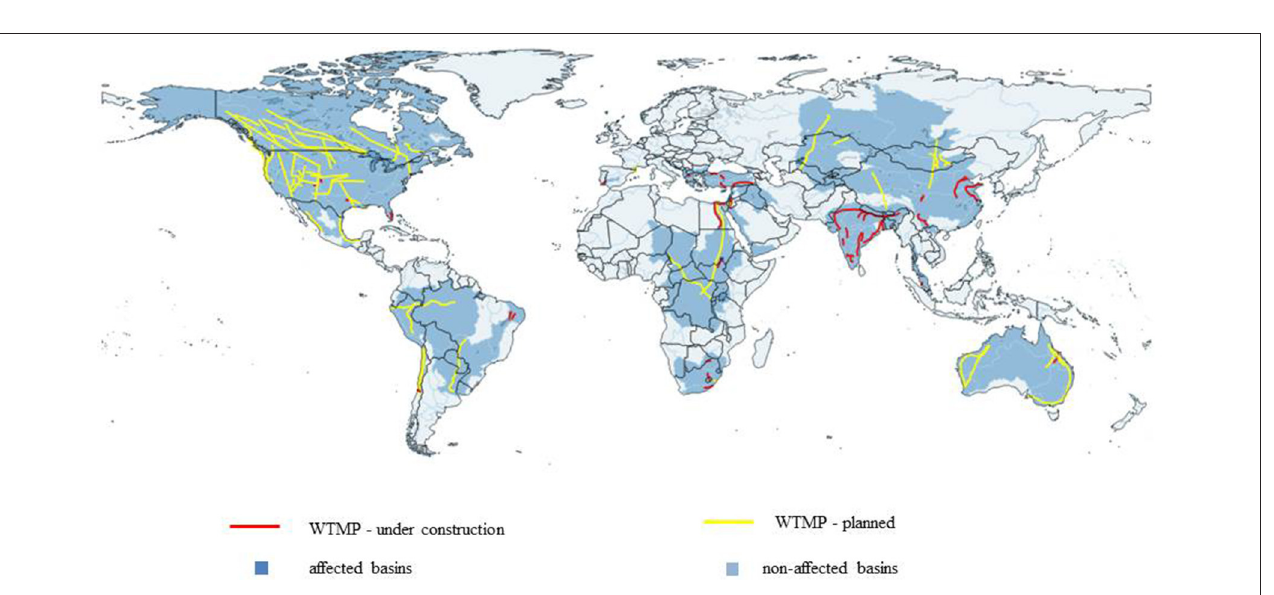
FIGURE 3 | Distribution of future WTMP under construction (red lines) or planned (yellow lines) across major river basins. Dark blue color shows major basins affected by water transfer, light blue shows non-affected basins. Black lines show countries